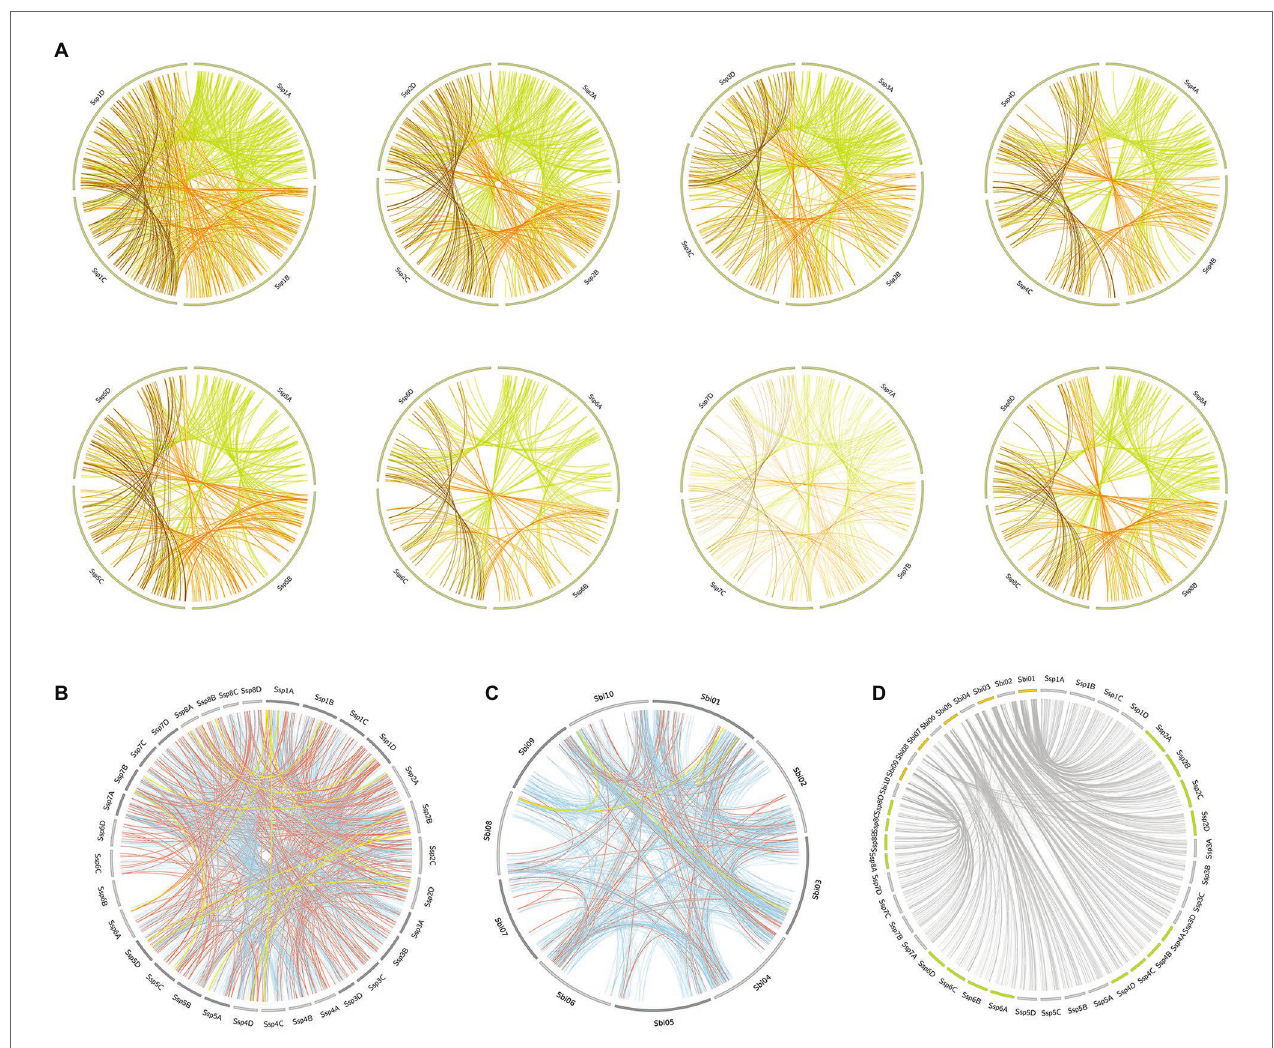
FIGURE 5 | Segmental duplication events in the Ssp and Sbi genomes, divided into (A) Ssp duplications between alleles on the same chromosome, with the colors representing the origin of the duplication (green for allele A , orange for allele B , and brown for allele C ). (B) Ssp duplications between chromosomes, excluding events between alleles on the same chromosome; and (C) Sbi duplications. The colors in (B,C) indicate the selection type of the gene pair duplication (orange indicates negative selection; light blue, positive selection; and yellow, neutral selection). (D) Representation of kinase correspondences between Sbi and Ssp., indicating the synteny relationships among these